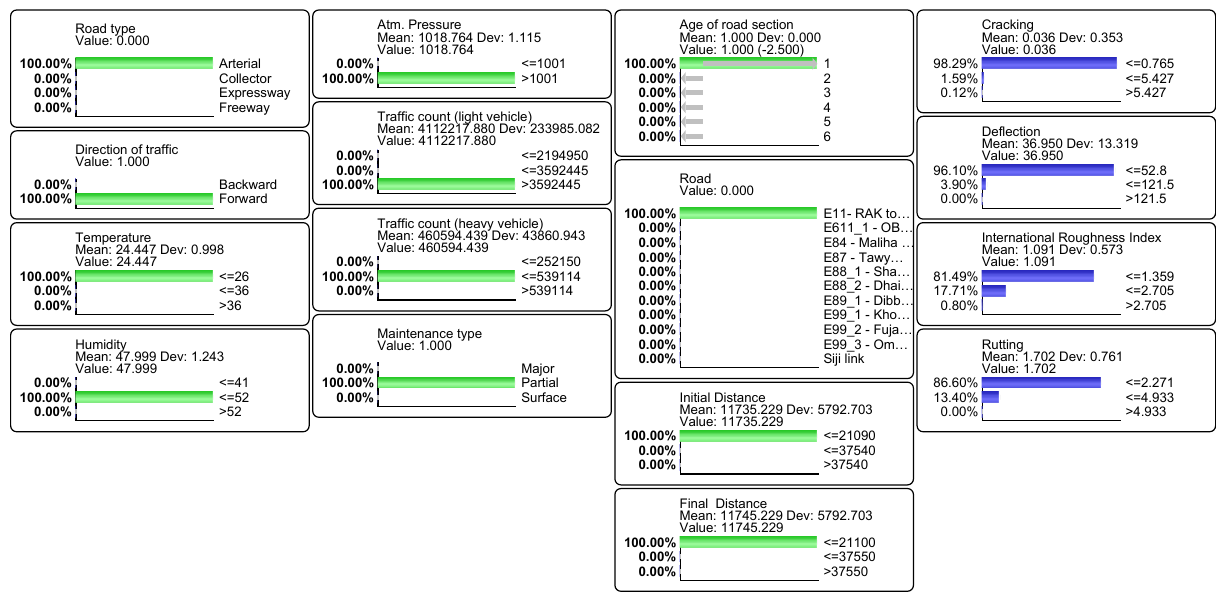
Figure 10. Testing of the BBN model.